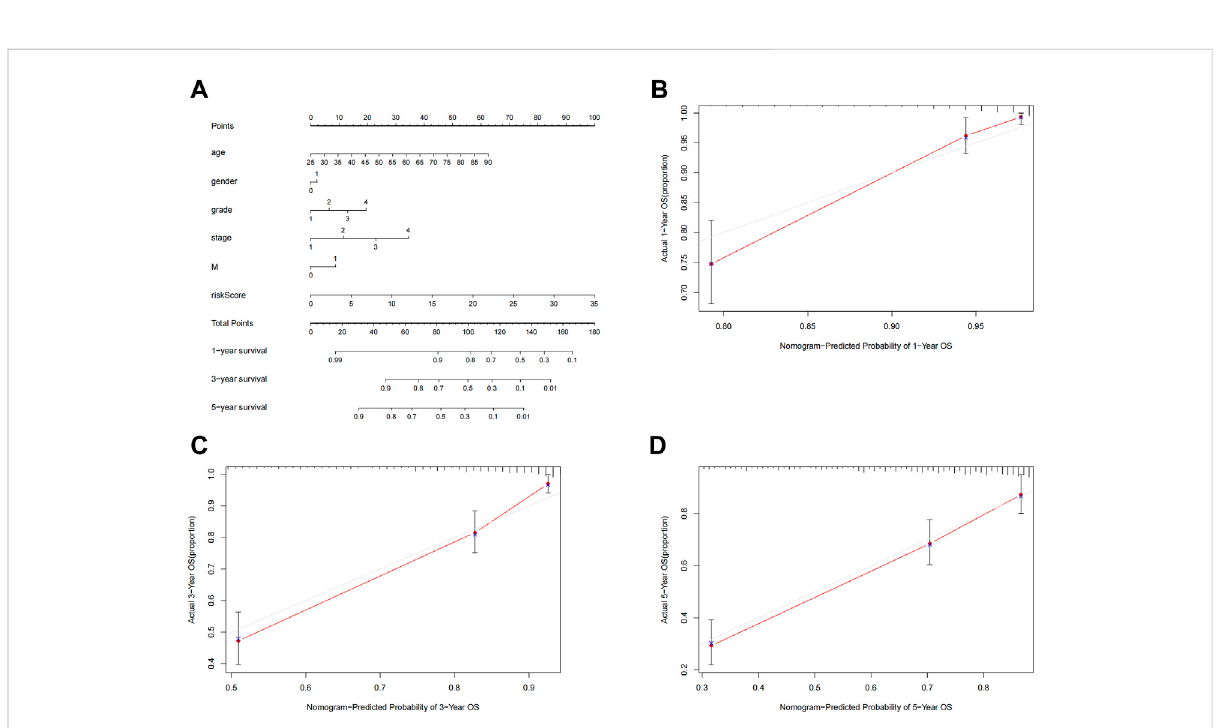
FIGURE 6 Nomogram construction and validation. (A) Nomogram survival combined with clinicopathological factors and risk score predicts 1-year, 3- year, and 5-year survival in ccRCC patients. (B – D) Calibration curve tests the consistency between actual OS rate and 1-year, 3-year and 5-year predicted survival. OS, overall survival; ccRCC, renal clear cell